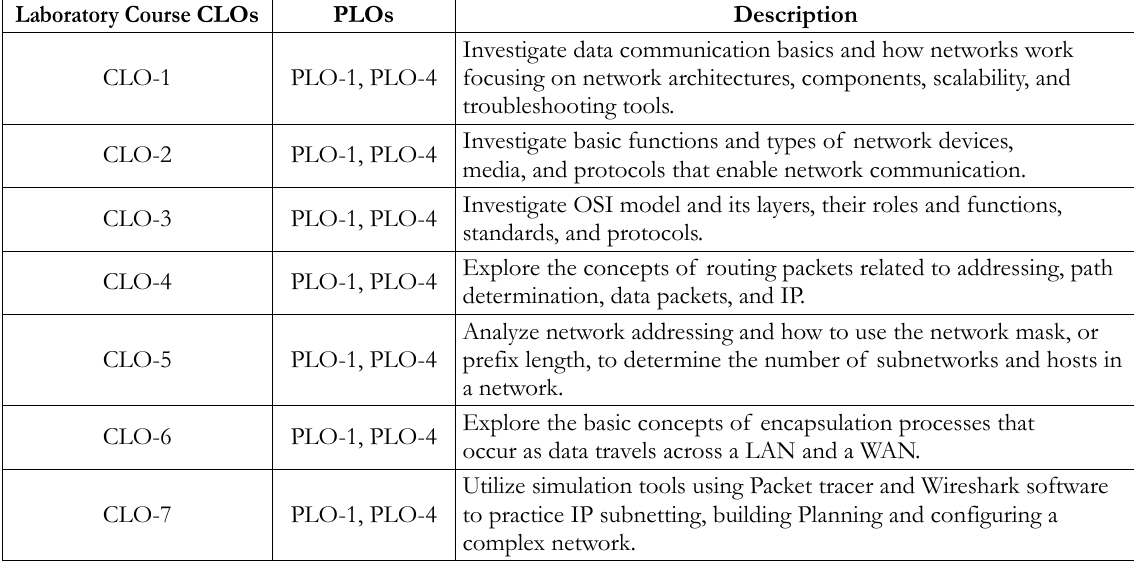
Table 3. The course learning outcomes for the lab course mapped to the program learning